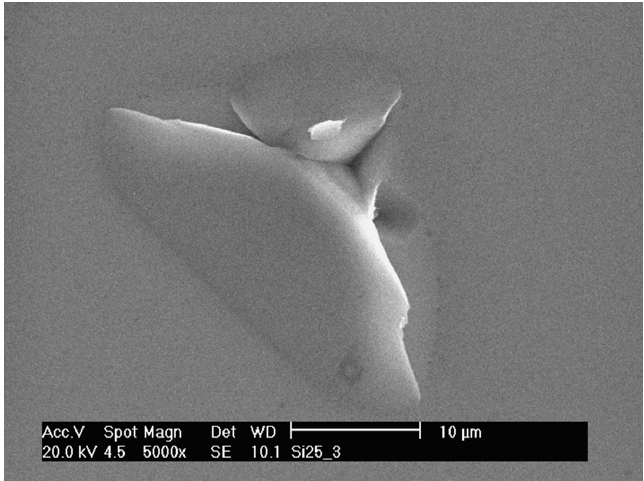
Figure 5. SEM micrograph of a 500 mN Berkovich indent, showing chipping flaws at the edges of the imprint.